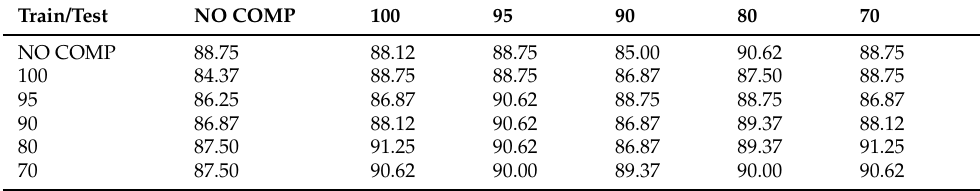
Table 11. Accuracy obtained by LM 136 with different JPEG quality factors (reported in